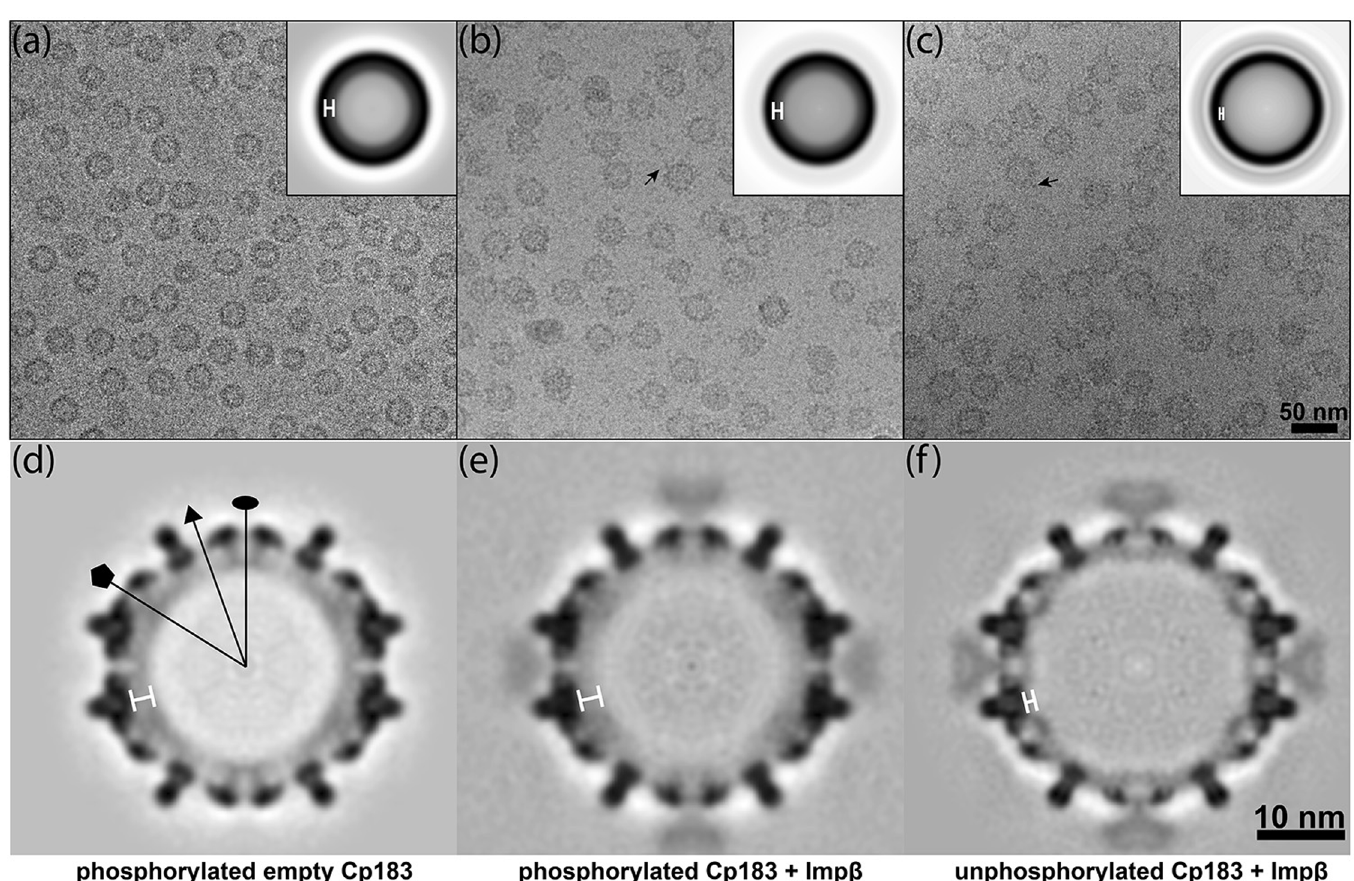
Fig 3. Cryo-EM analysis of Cp183 capsids complexed with Imp β . Typical cryo-EM micrographs of (a) P-Cp183, (b) P-Cp183-Imp β , and (c) Cp183-Imp β and (d-f) central sections of their respective reconstructions. Insets in the micrographs show enlarged, translationally and rotationally aligned average images. Black arrows in the micrographs point to examples of Imp β decorating the capsids. In reconstructions, the Imp β is found at the twofold vertices on the Cp183 capsid surface. CTDs are localized to the annulus indicated by the white bars in the rotationally aligned images and the density maps. The P-Cp183 capsids show stronger CTD density at their fivefold vertices consistent with clustering of CTDs previously described in reference [13]. The capsid- Imp β complexes were prepared from Cp183 capsid (7.9 μ M dimer) and 5.3 μ M Imp β . Oval, triangle, and pentagon symbols in panel d indicate locations of twofold, threefold and fivefold axes, respectively. The resolution of the maps shown in panels d-f are 10.1 Å , 10.9 Å , and 10.2 Å , respectively, based on Fourier Shell Correlation (FSC) gold standard methodology using an FSC cutoff of 0.143 (S2 Table).